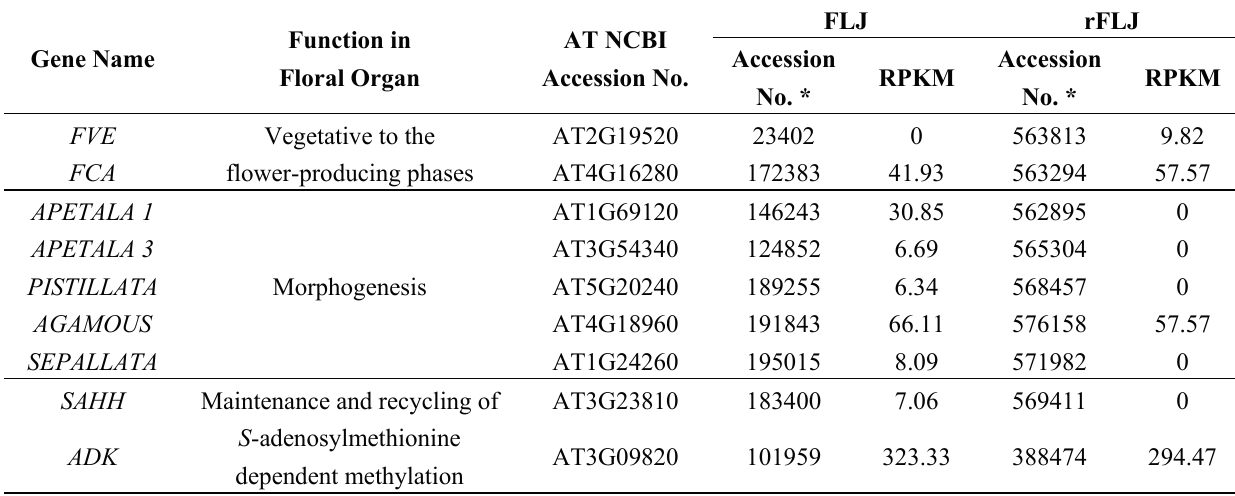
Table 2. Gene expression of floral developmental genes in Lonicera japonica and its wild